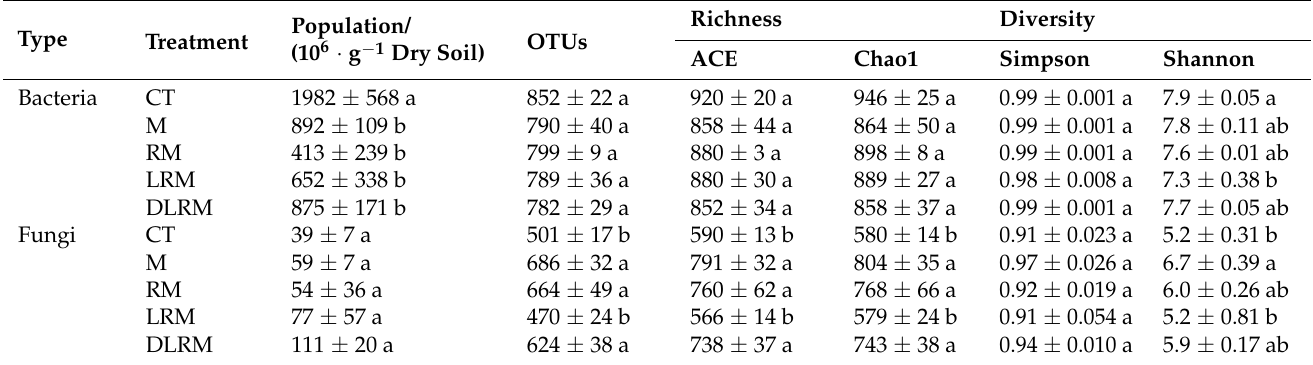
Table 3. Soil microbial population, OTUs, and alpha diversity in different treatments.